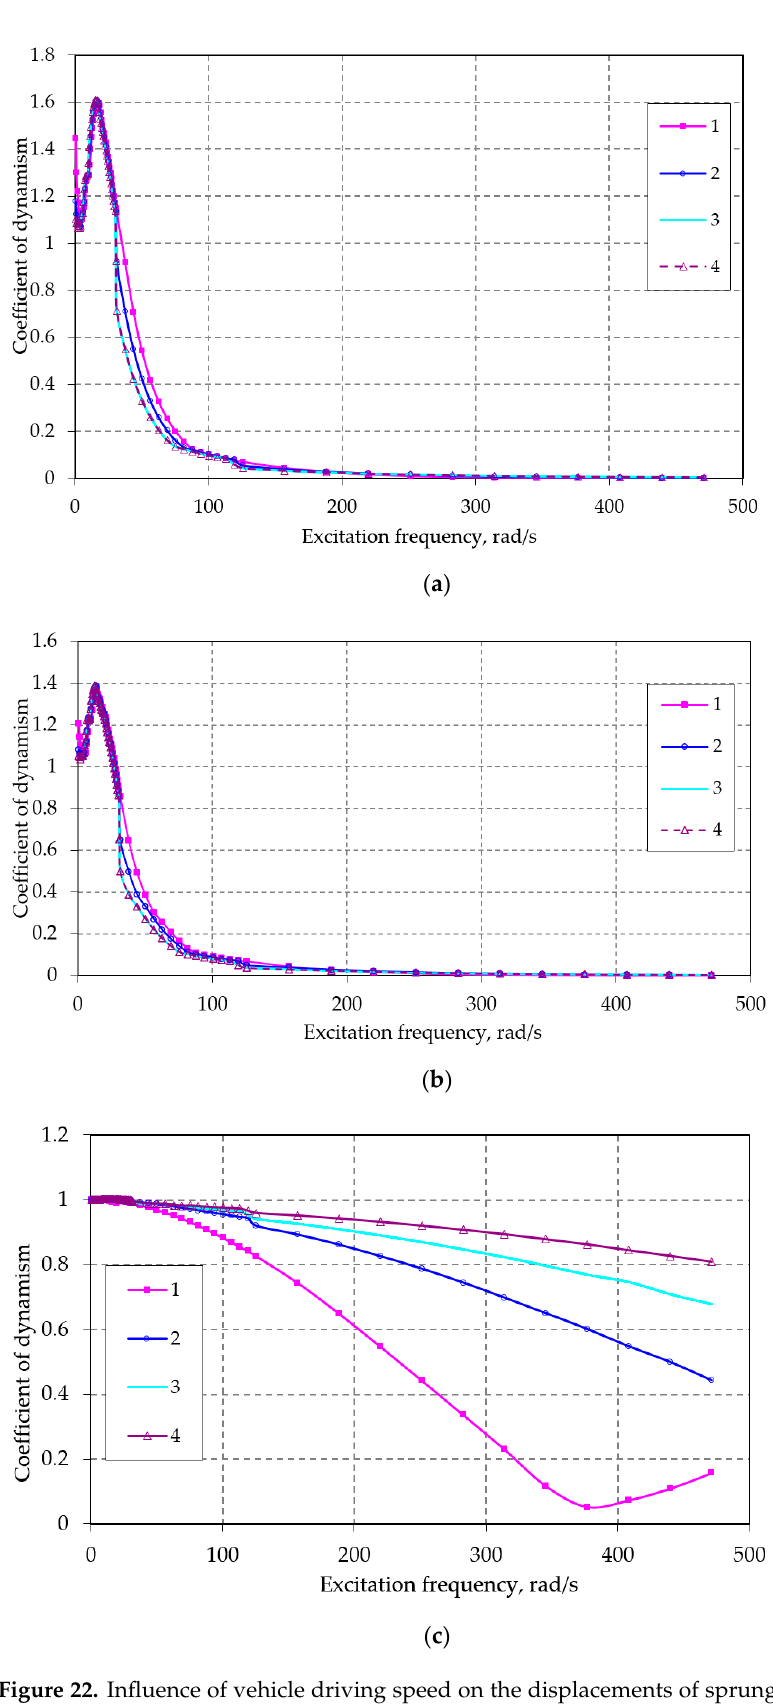
Figure 22. Influence of vehicle driving speed on the displacements of sprung mass ( a ), unsprung mass ( b ), and tire tread ( c ): 1—vehicle speed 10 m/s; 2—20 m/s; 3—30 m/s; and 4—40